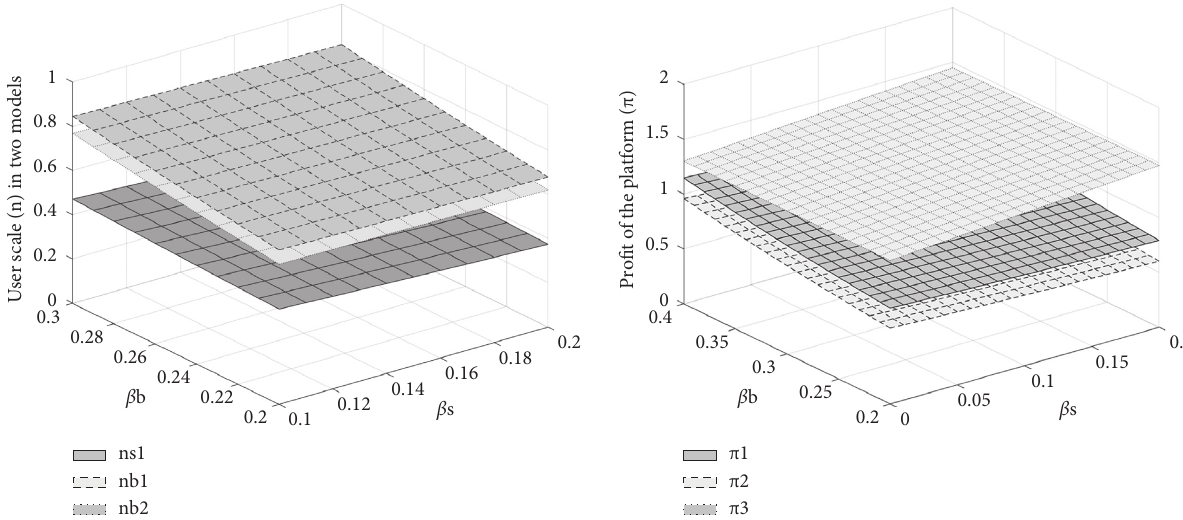
Figure 3: The impact of intragroup network externality on user scale and